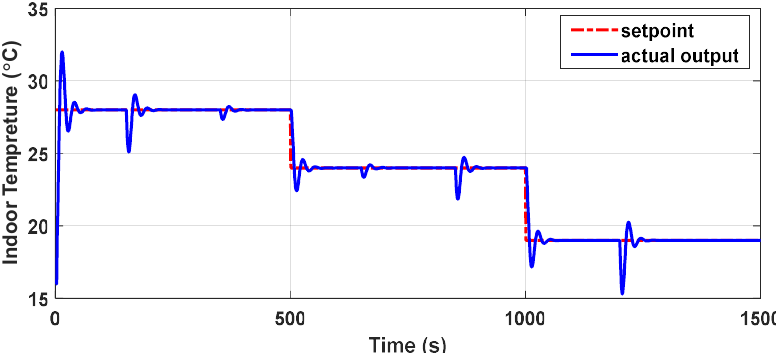
Figure 8. Response of inside temperature.